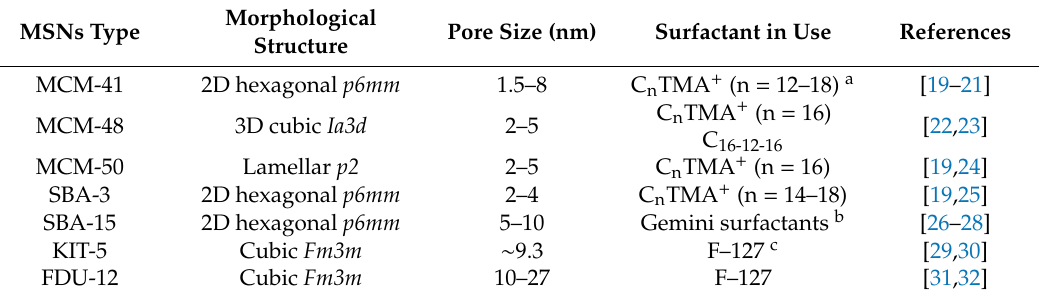
Table 1. Common types of mesoporous silica nanoparticles